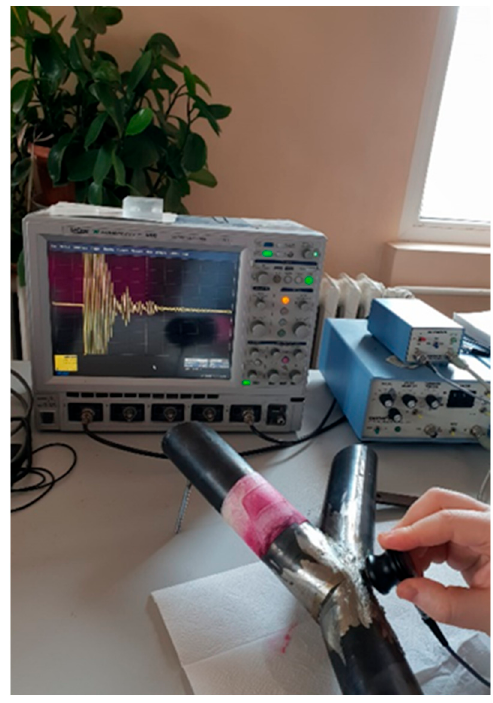
Figure 3. Non-destructive tests for welding lines. Table 1. Properties of the devices used in the experimental tests.